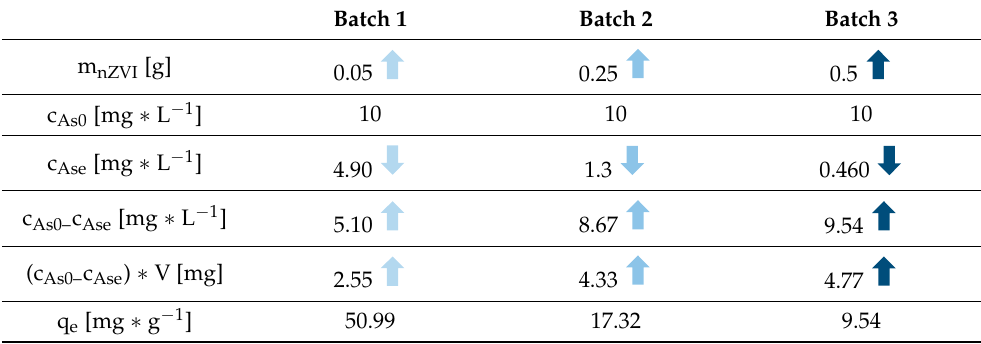
Table 6. The amount of adsorbed As at equilibrium in mg ∗ g − 1 for Test